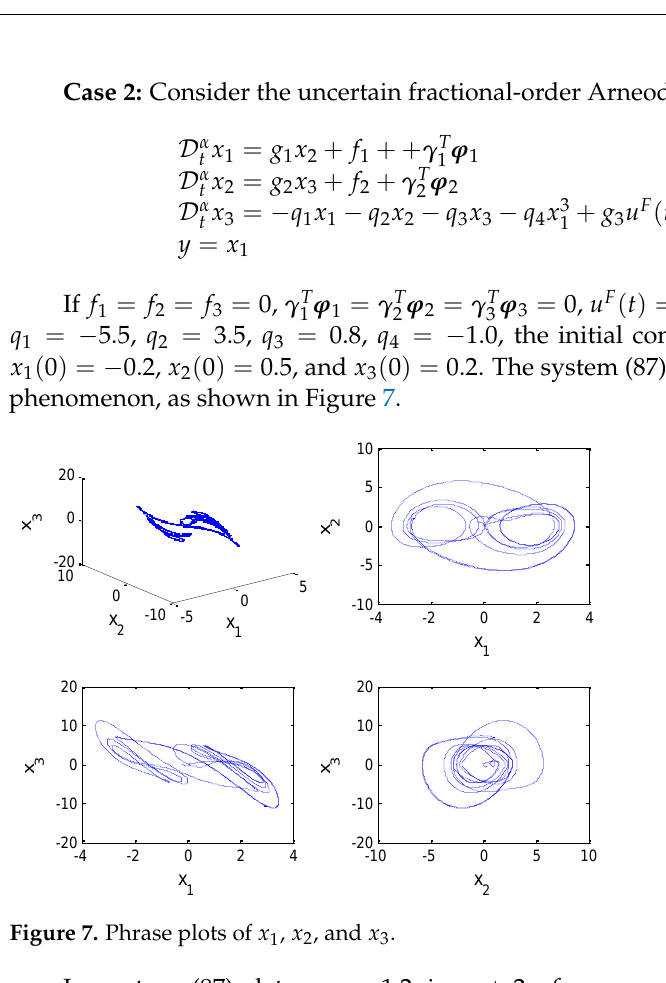
. The parameters selection of the second-order command